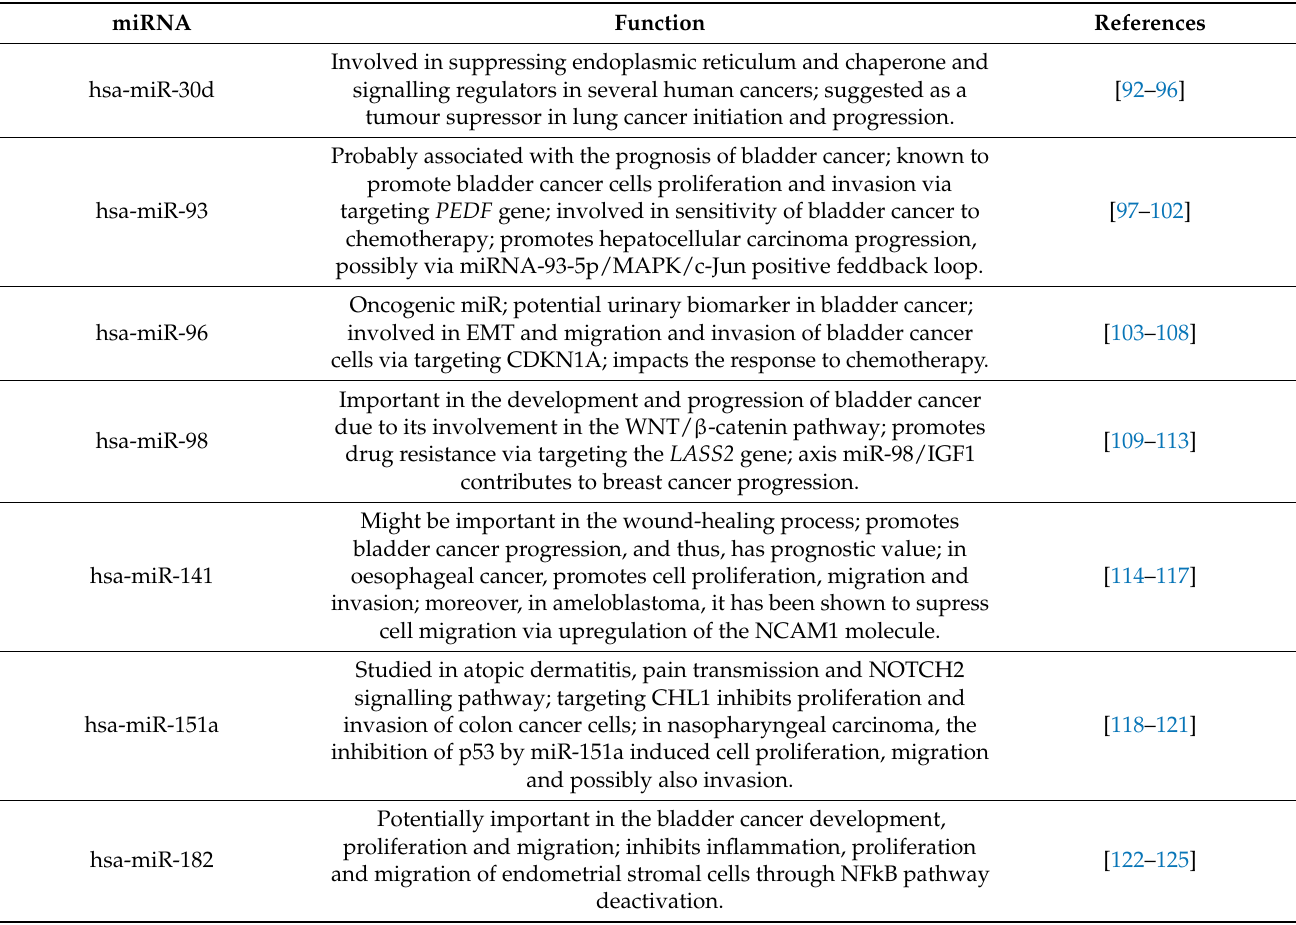
Table 2. The most negatively correlated miRNAs and their known functions in human cancers, including bladder cancer, if such a function is reported. miRNA